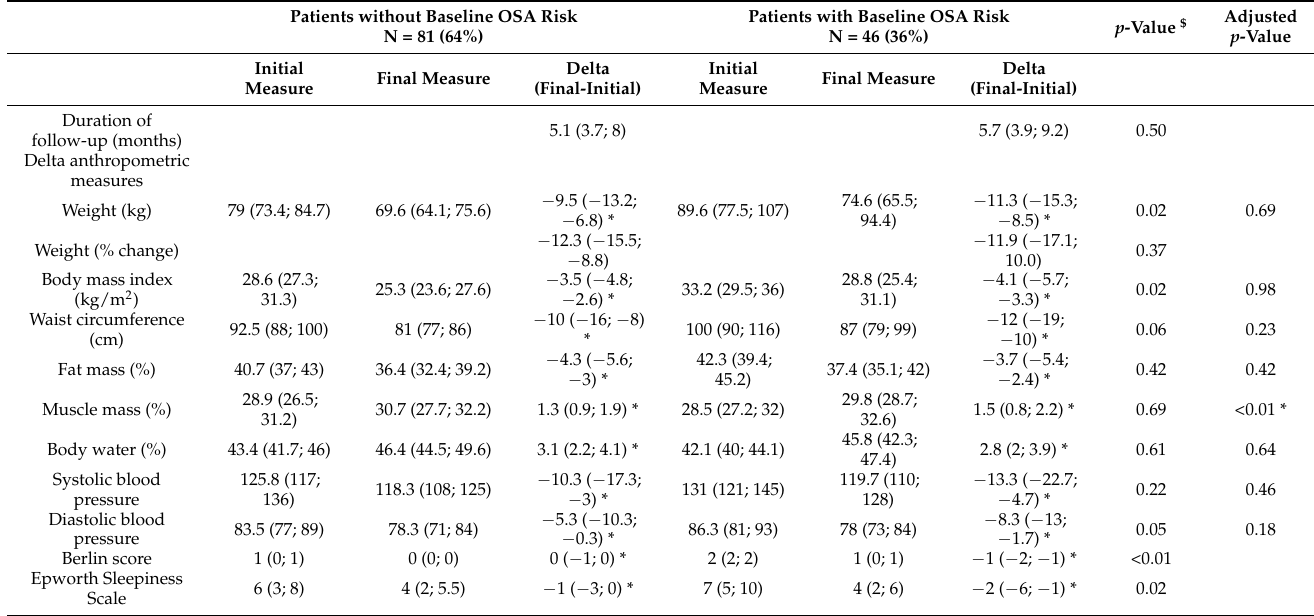
Table 3. Evolution of anthropometric measures, OSA risk, and ESS score over time during weight-loss